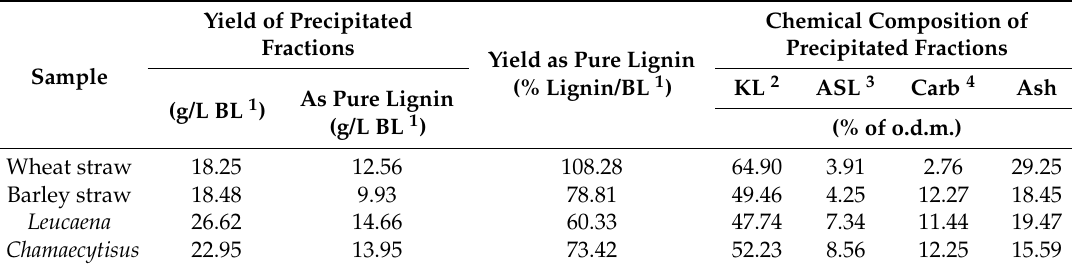
Table 2. Yield and composition of lignin